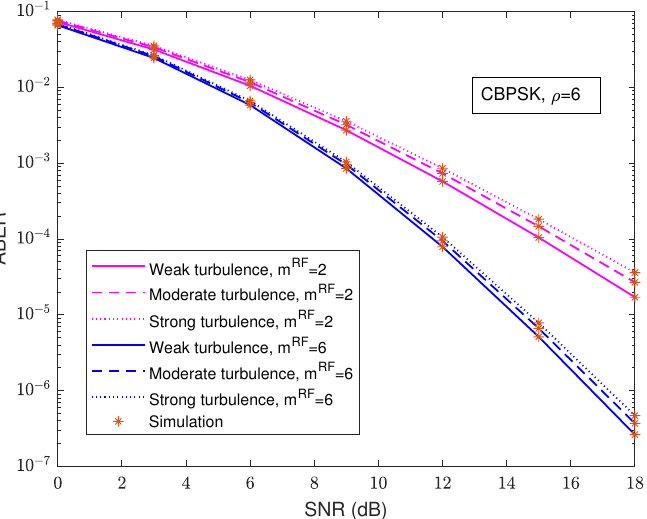
Figure 3. The ABER of the hybrid FSO/RF direct link under different turbulence intensity and RF fading